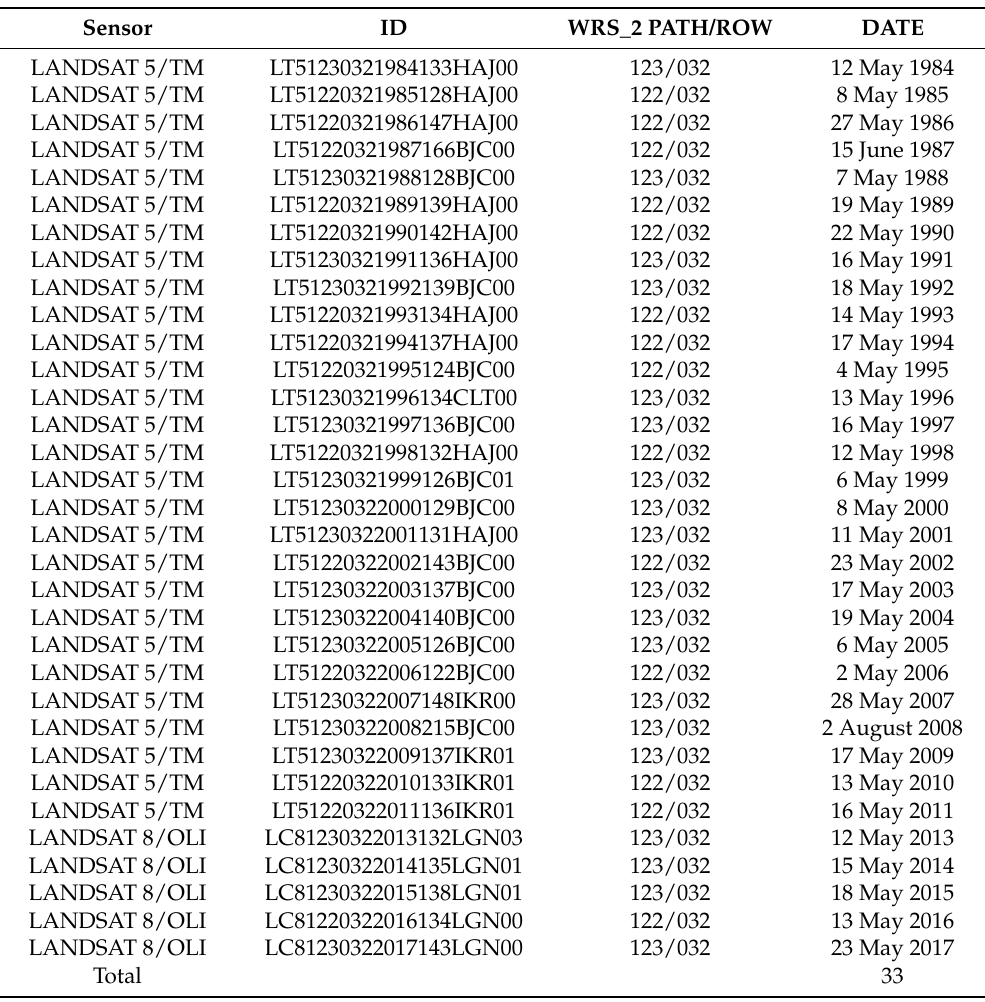
Table A1. Detailed information of all Landsat images that we used in this study.